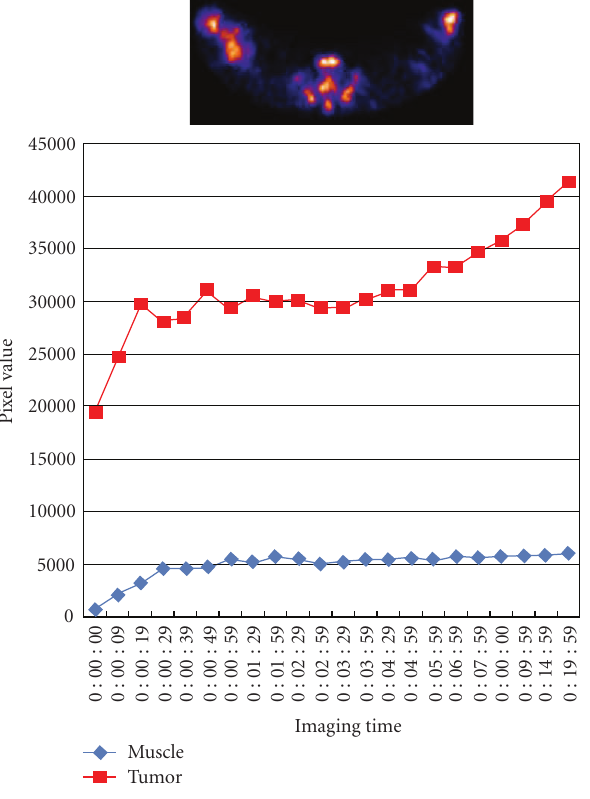
Figure 9: 45 Minutes dynamic tumor uptake of 68 Ga-GP in a New Zealand white rabbit bearing VX2 tumor. The axial view from PET- CT showed the location of tumor.